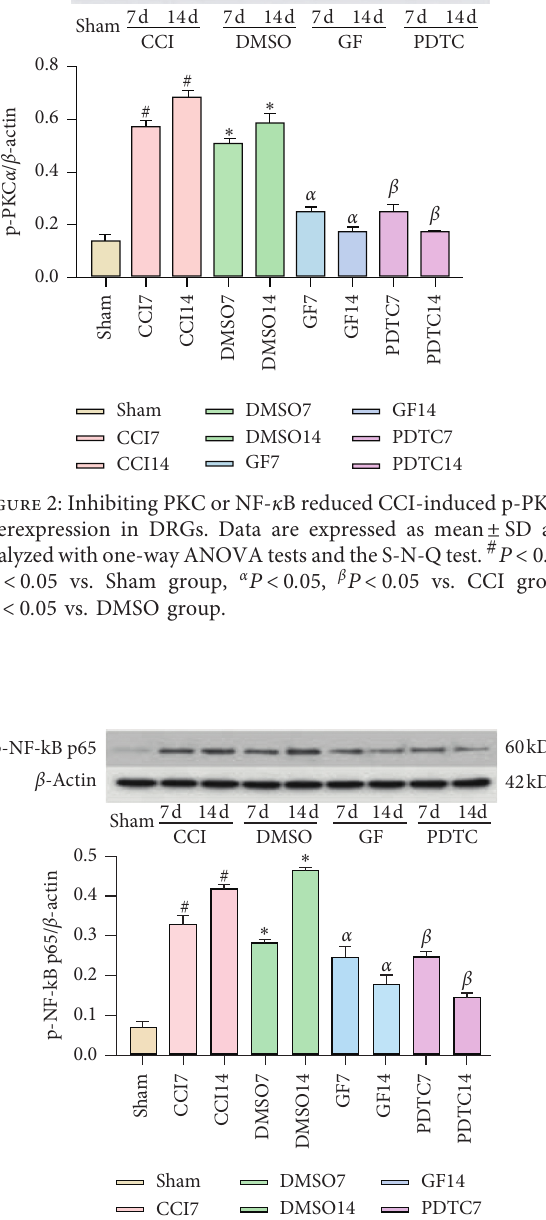
Figure 3: Inhibiting PKC and NF- κ B reduced CCI-induced p-NF- κ B p65 overexpression in DRGs. Data are expressed as mean ± SD and analyzed with one-way ANOVA tests and the S-N-Q test. # P < 0 . 05, ∗ P < 0 . 05 vs. Sham group, α P < 0 . 05, β P < 0 . 05 vs. CCI group, α P < 0 . 05 vs. DMSO group.